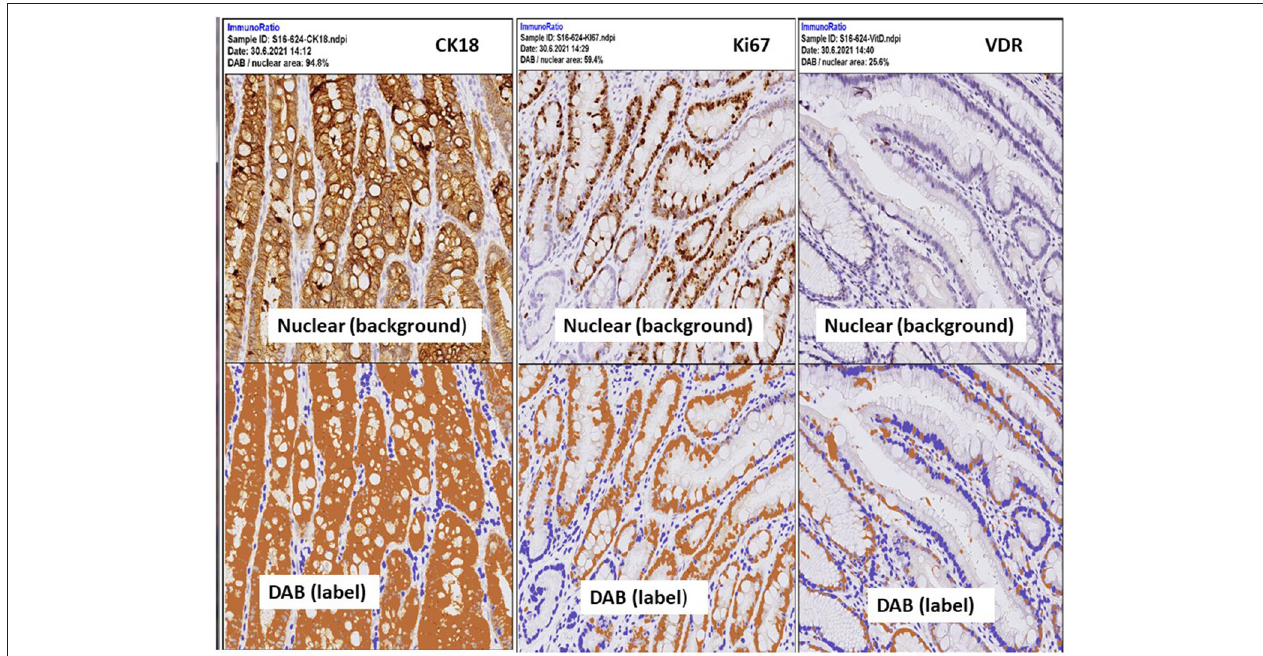
FIGURE 6 | IHC expressions by ImmunoRatio (ImageJ plugin software) processed from one patient with stage I, poor differentiated type gastric adenocarcinoma. Upper panel: the original hematoxylin image (total cell). Lower panel: “DAB” indicates labeled cells, a pseudo-colored image showing the segmented staining components. Labeling index is calculated by the percentage of DAB (positively stained cells) divided the total cell. Left: 94.8% by CK18, middle: 59.4% by Ki67, right: 25.8% by VDR.